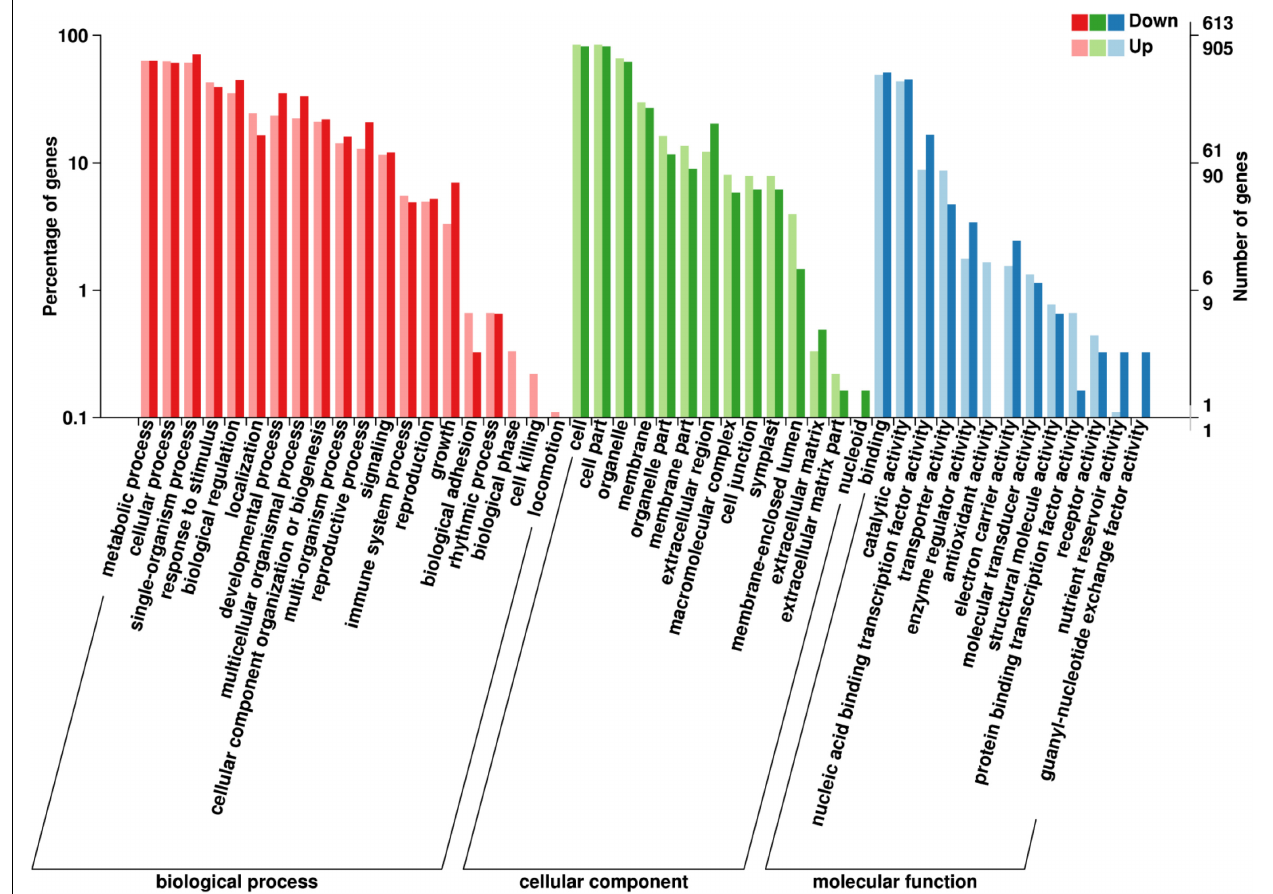
FIGURE 6 | GO annotation of differentially expressed genes (DEGs) between fertile and sterile buds. The x -axis shows the terms in the three GO categories, the left y -axis shows the percentage of DEGs enriched in a specific term (out of all the DEGs in each category), and the right y -axis shows the number of DEGs enriched in a specific